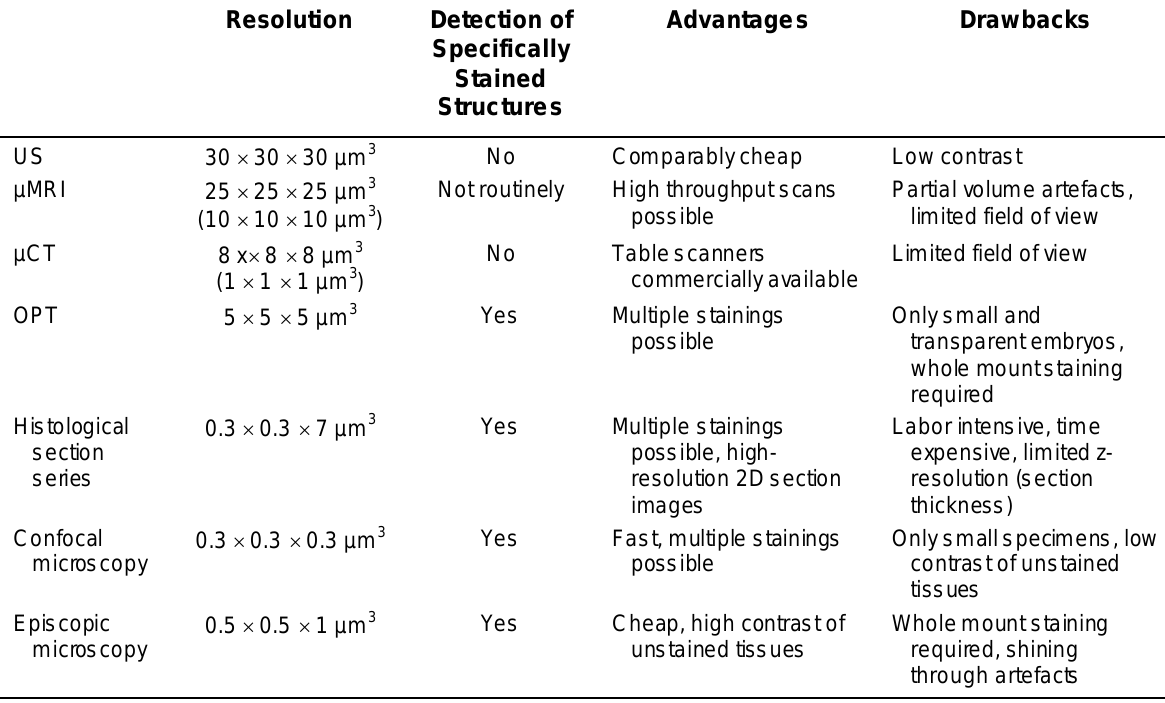
3D Imaging Techniques for Visualizing Vertebrate Embryos* Resolution Detection of Advantages Drawbacks Specifically Stained Structures Partial volume artefacts, Limited field of commercially available